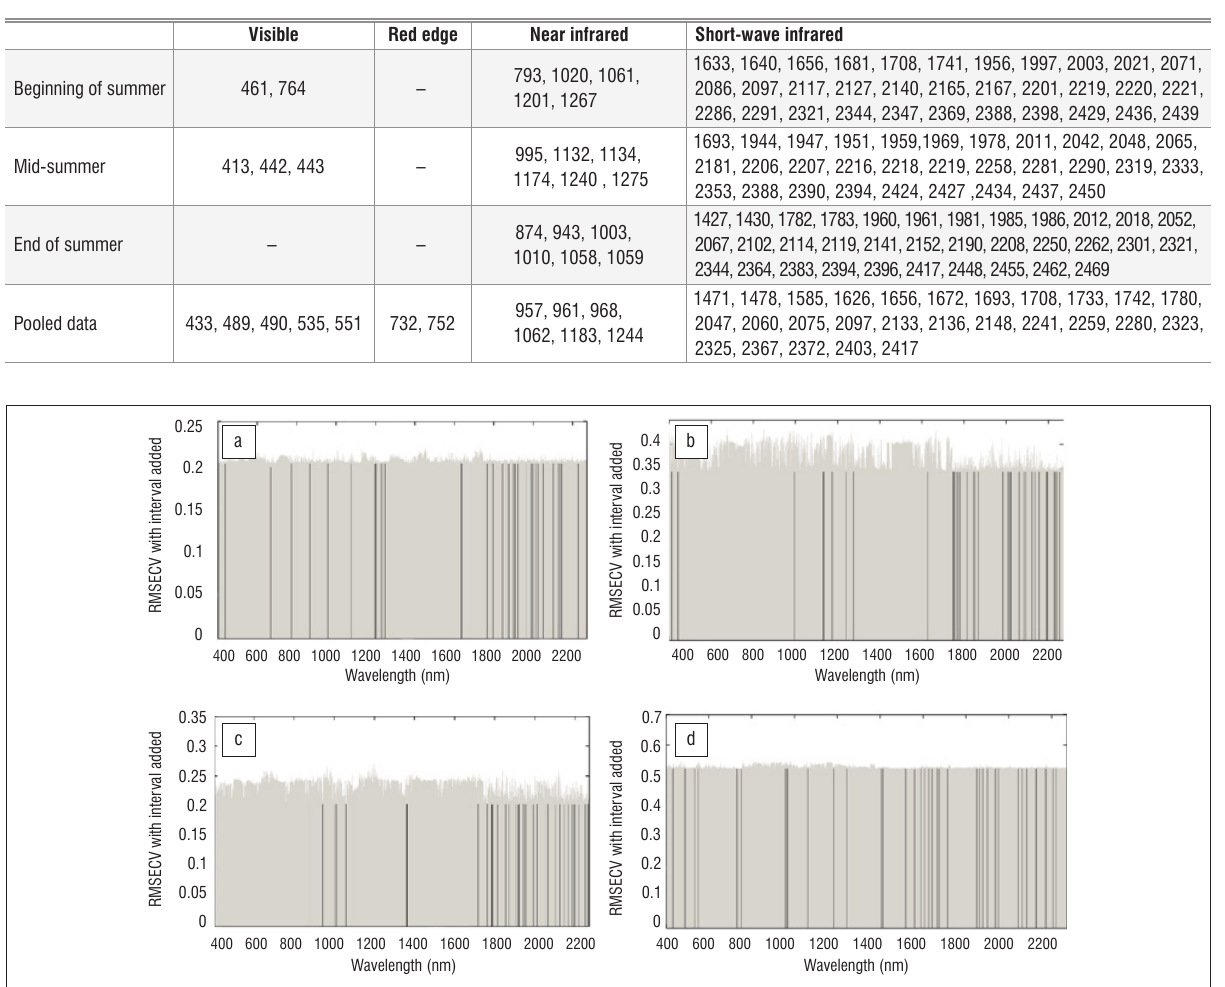
1471, 1478, 1585, 1626, 1656, 1672, 1693, 1708, 1733, 1742, 1780, 2047, 2060, 2075, 2097, 2133, 2136, 2148, 2241, 2259, 2280, 2323,